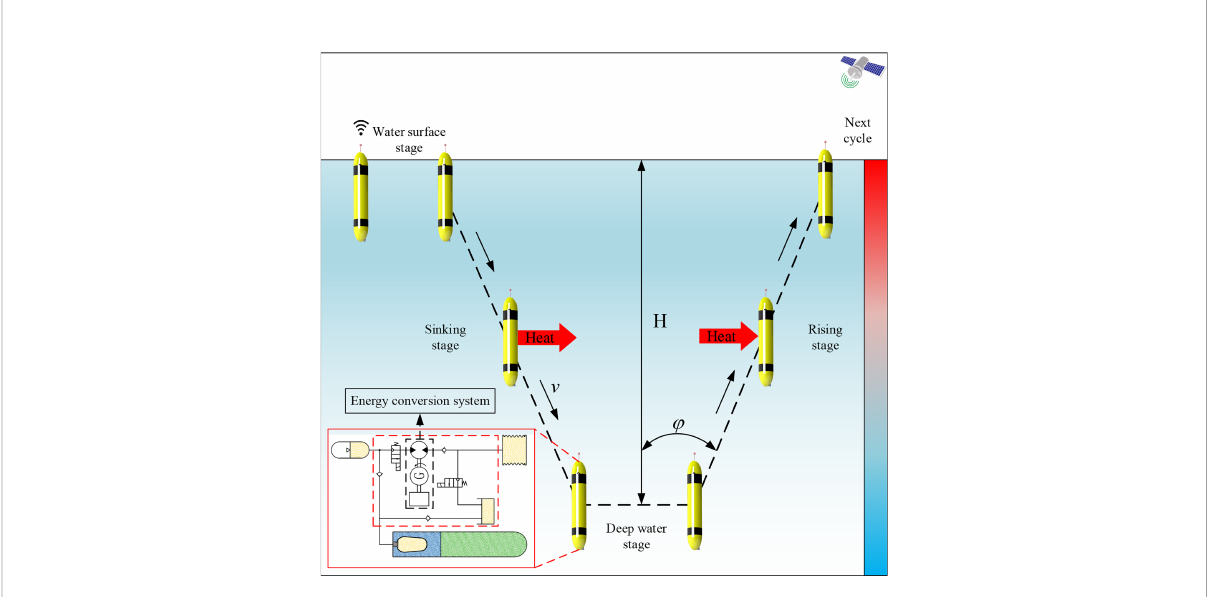
FIGURE 1 The principle of the operation and the energy conversion for the